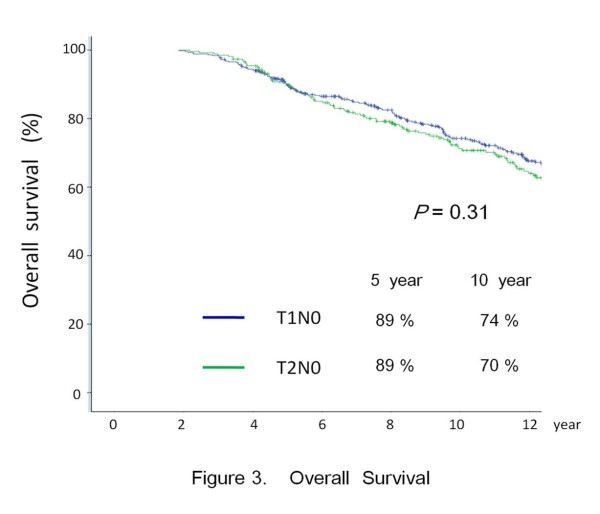
Overall survival.